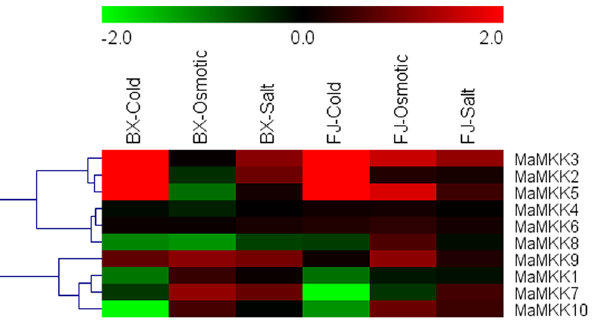
Figure 9. Expression profiles of banana MAPKKs in response to cold, osmotic and salt treatments in BX and FJ varieties. Log2 based FPKM value was used to create the heat map. Changes in gene expression are shown in color as the scale.